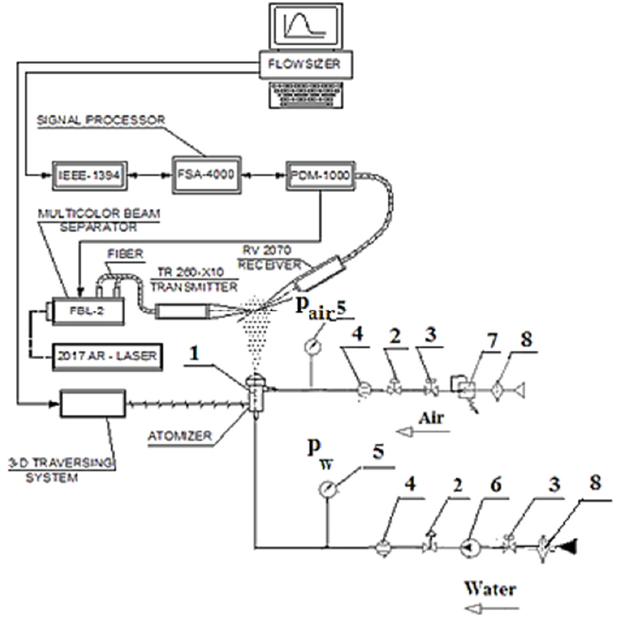
Figure 4. A scheme of the test rig: 1—atomizer, 2—control valve, 3—shut-off valve, 4—flow meter, 5—pressure gauge, 6—water pump, 7—air pressure regulator, 8—filter.